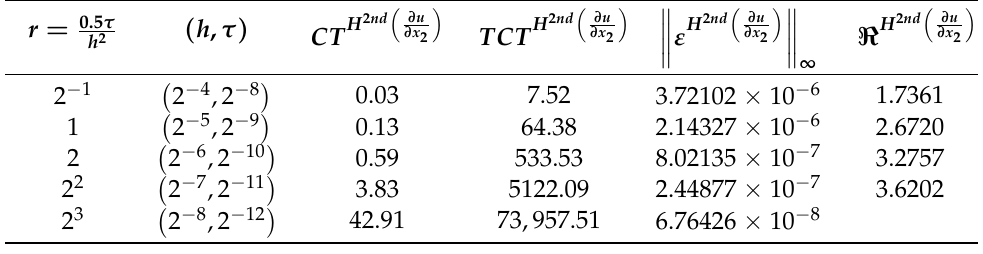
Table 4. Computational time, maximum norm of the errors, and the order of convergence of z h , τ to the exact derivative z = ∂ u